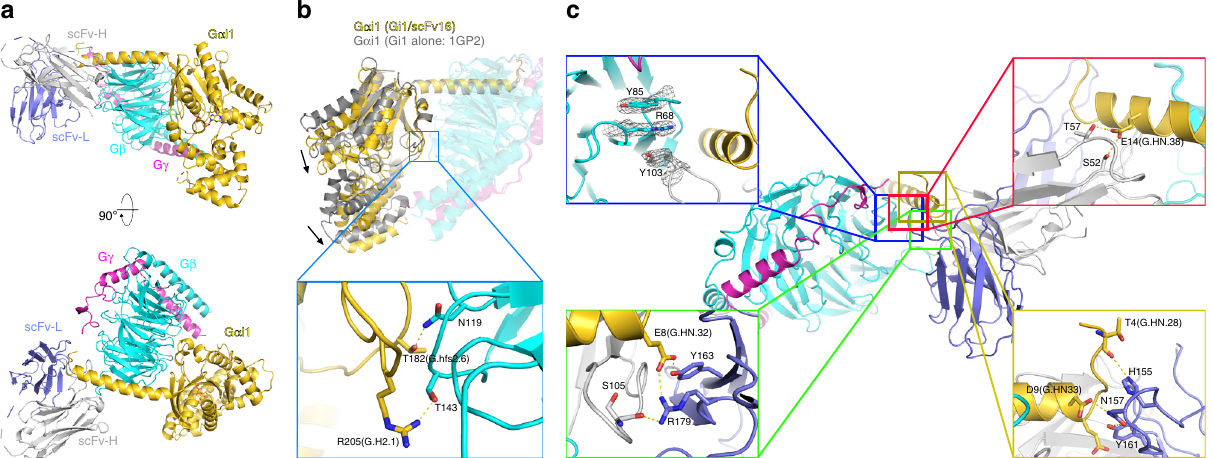
Fig. 2 Crystal structure of G i1 /scFv16 and characterization of Fab16. a Overall structure of Gi1/scFv16 complex. Cartoon representation with G α i1 in gold, G β in cyan, G γ in magenta, scFv-heavy chain in light grey and scFv-light chain in light blue. b Superposition of G i1 /scFv16 structure onto G i1 (PDB: 1GP2) based on alignment of G βγ subunits. G α i1 (1GP2) in grey and G i1 /scFv16 in the same colour code as in a . For clarity, G βγ subunits and scFv16 is shown as transparent cartoon. Arrows show a slight rotational displacement of G α i1 towards G β 1 compared to Gi1 alone. Additional interactions are formed between switch I and switch II of G α i1 and G β 1 . c Interaction between G i1 and scFv16. The residues participating in the interactions are depicted with stick models in the expanded panels. Residue numbers are shown with Common G α Numbering (CGN) code for G α i1